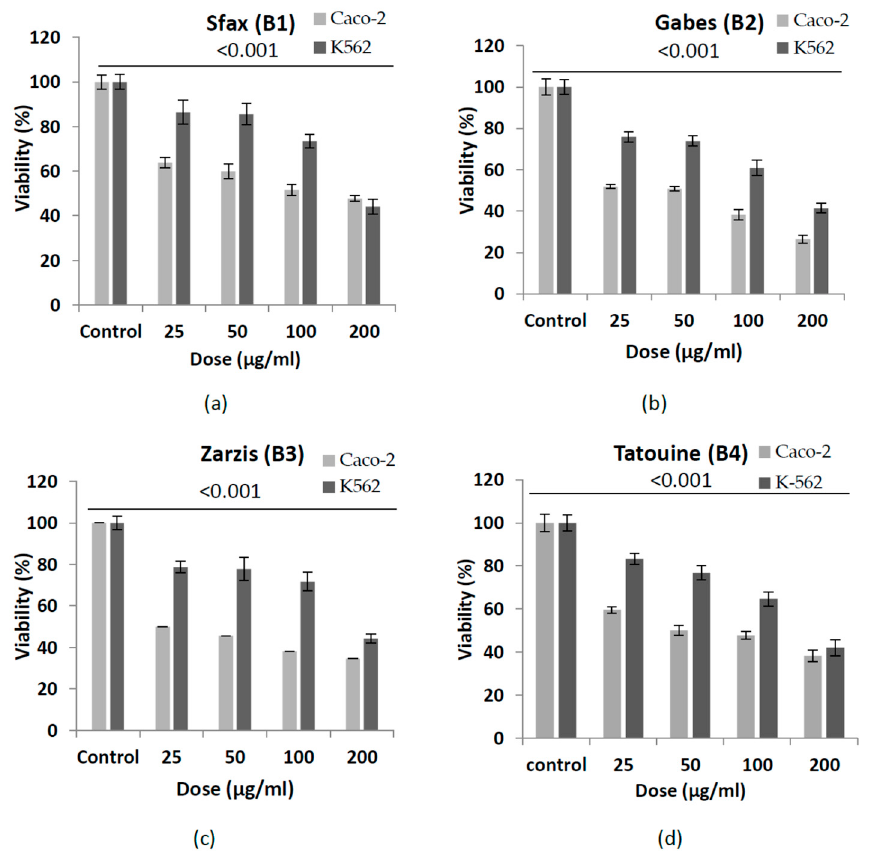
Figure 2. Antiproliferative activity of the four extracts of Brassica tournefortii growing in different regions of southern Tunisia, tested on two neoplastic cell lines (K-562 and Caco-2). ( a ) B. tournefortii samples collected from Sfax (B1); ( b ) B. tournefortii samples collected from Gabes (B2); ( c ) B. tournefortii samples collected from Zarzis (B3); ( d ) B. tournefortii samples collected from Tatouine (B4). Data are the mean of three replicates ± SD. The unpaired Student’s t -test indicates significant differences compared with the untreated cells (control) ( p < 0.001). Table 3. IC 50 (µg/mL) of four B. tournefortii extracts tested on Caco-2 and K-562 cell lines .